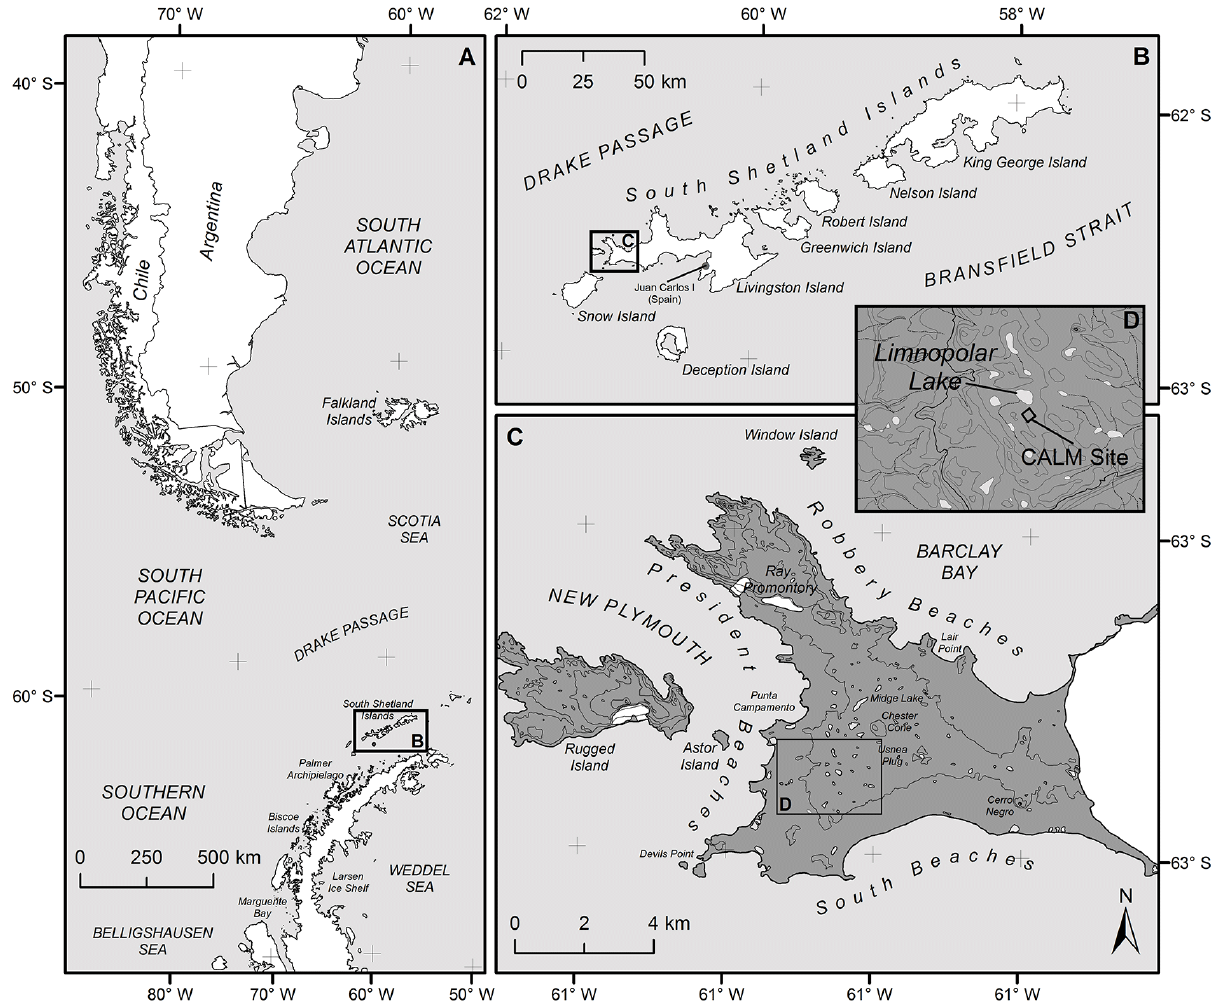
Figure 1. Location of the Limnopolar Lake CALM site (A25) on Byers Peninsula, Livingston Island, in the South Shetland archipelago,